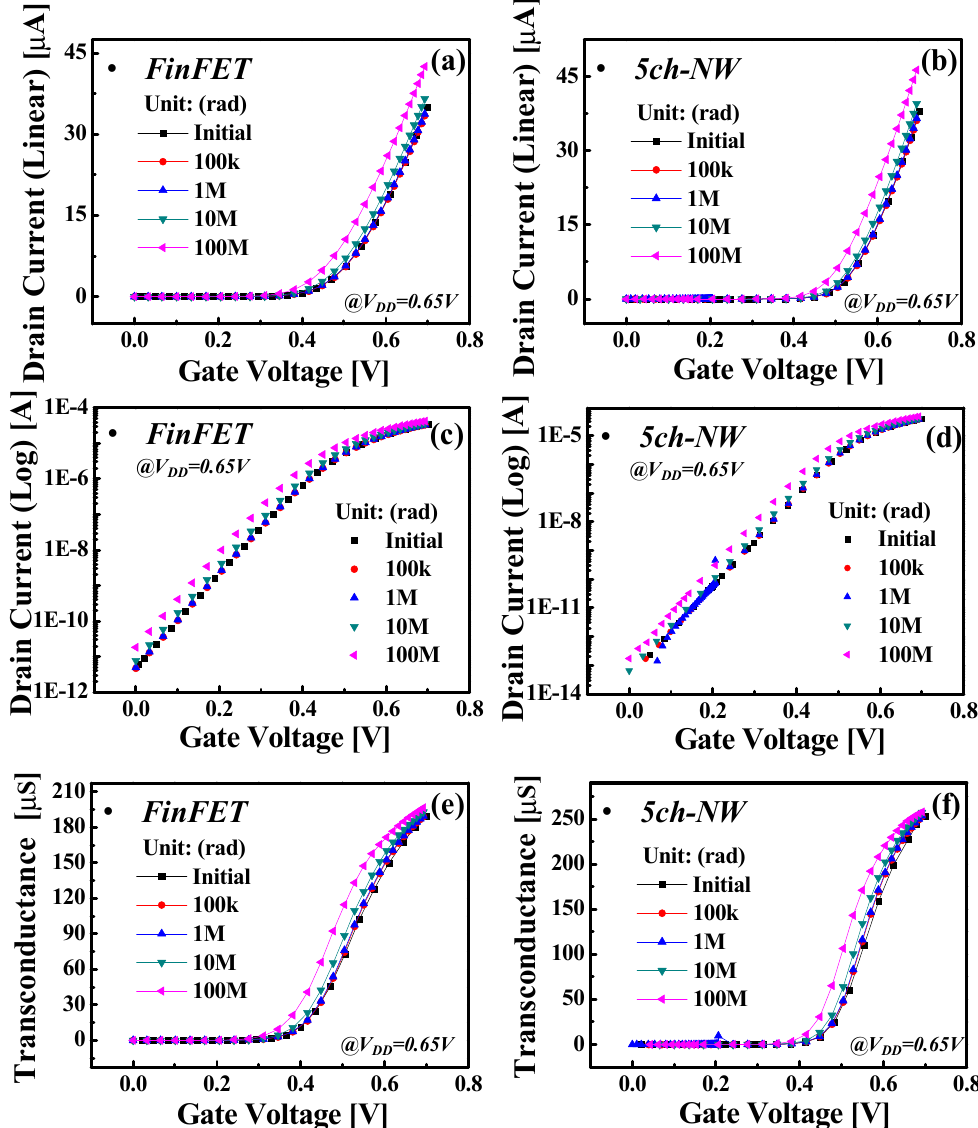
Figure 5. I D -V G curve shifts with an increasing radiation dose up to 100 Mrad for ( a ) FinFET, and ( b ) 5ch-NW. The I D -V G curves were extracted at 100 krad, 1 Mrad, 10 Mrad, and 100 Mrad. These graphs were obtained by sweeping V DD = 0.65 V and V G from 0 V to 0.7 V when the total dose was reached. ( c , d ) are the I D -V G curve graph of the log scale of each device according to the TID effect. ( c ) is the FinFET’s log scale curve, ( d ) is the 5ch-NW’s log scale curve, ( e ) is the FinFET’s transconductance graph, and ( f ) is the 5ch-NW’s transconductance